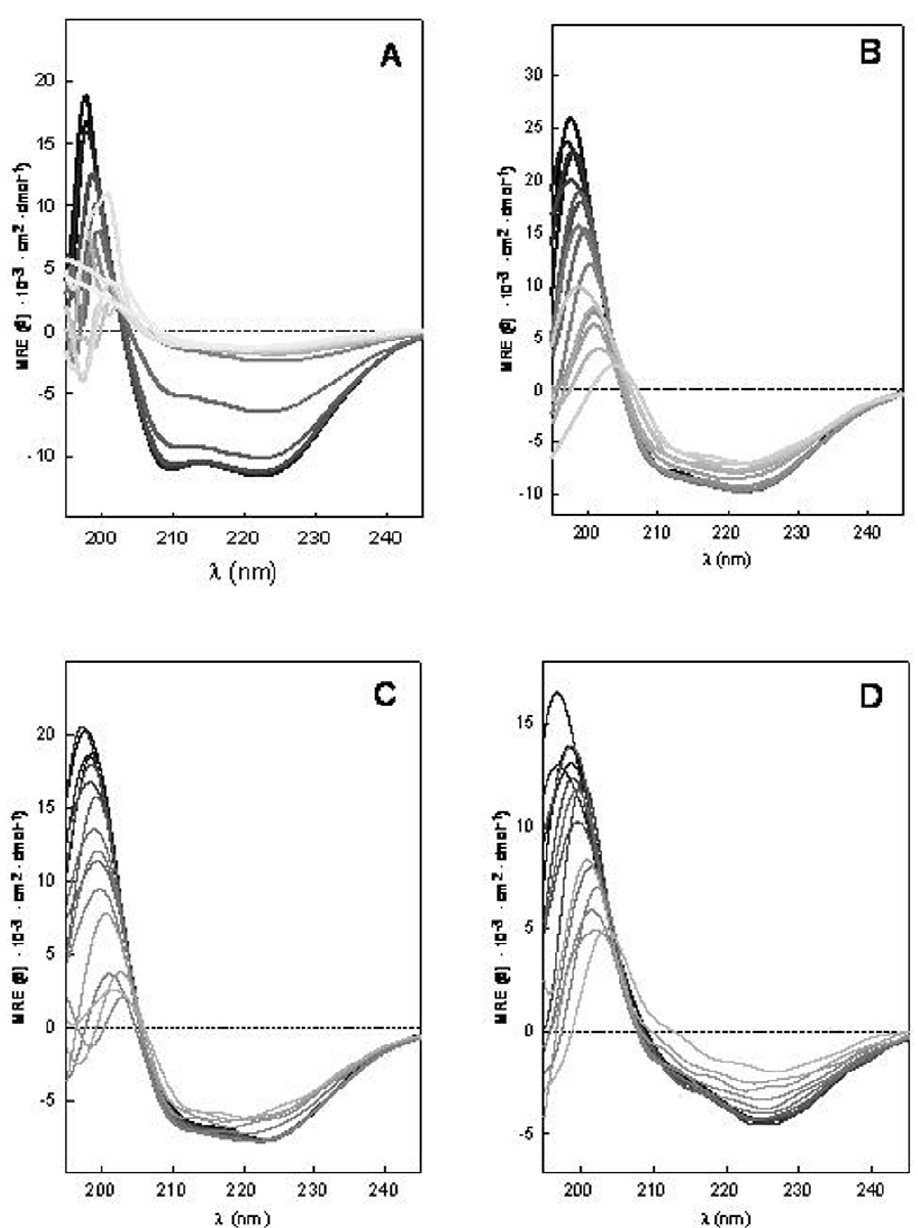
Figure 2. Thermal unfolding of the secondary structure of SoPIP2;1. Protein was reconstituted in A) OG micelles, B) E. coli lipid membranes, C) POPE:POPC:POPS:Ergosterol membranes and D) POPE:POPC membranes. Temperatures are represented by the grayscale colors from black, 20 u C to very light gray, 95 u C. doi:10.1371/journal.pone.0014674.g002 structure of the protein. Thus the Trp is generally blue-shifted from 350 nm in environments of low polarity such as the hydrophobic interior of a protein or in a lipid membrane environment and Trp fluorescence in proteins has been classified into five classes by Reshetnyak et al. [34]. According to this classification, the dominant fluorescence around 329 nm corre- sponds to a class of Trp side chains that are in a relatively non- polar environment and H-bonded in an 2:1 exciplex that fluoresces at 331 nm [34]. Inspection of the three-dimensional structure of SoPIP2;1 indicated that the Trps of this protein are positioned close to the surface of the protein (see cartoon i in Figure 5A) [22]. SoPIP2;1 reconstituted into detergent-micelles offers a more extensive hydrophobic surface for interaction with